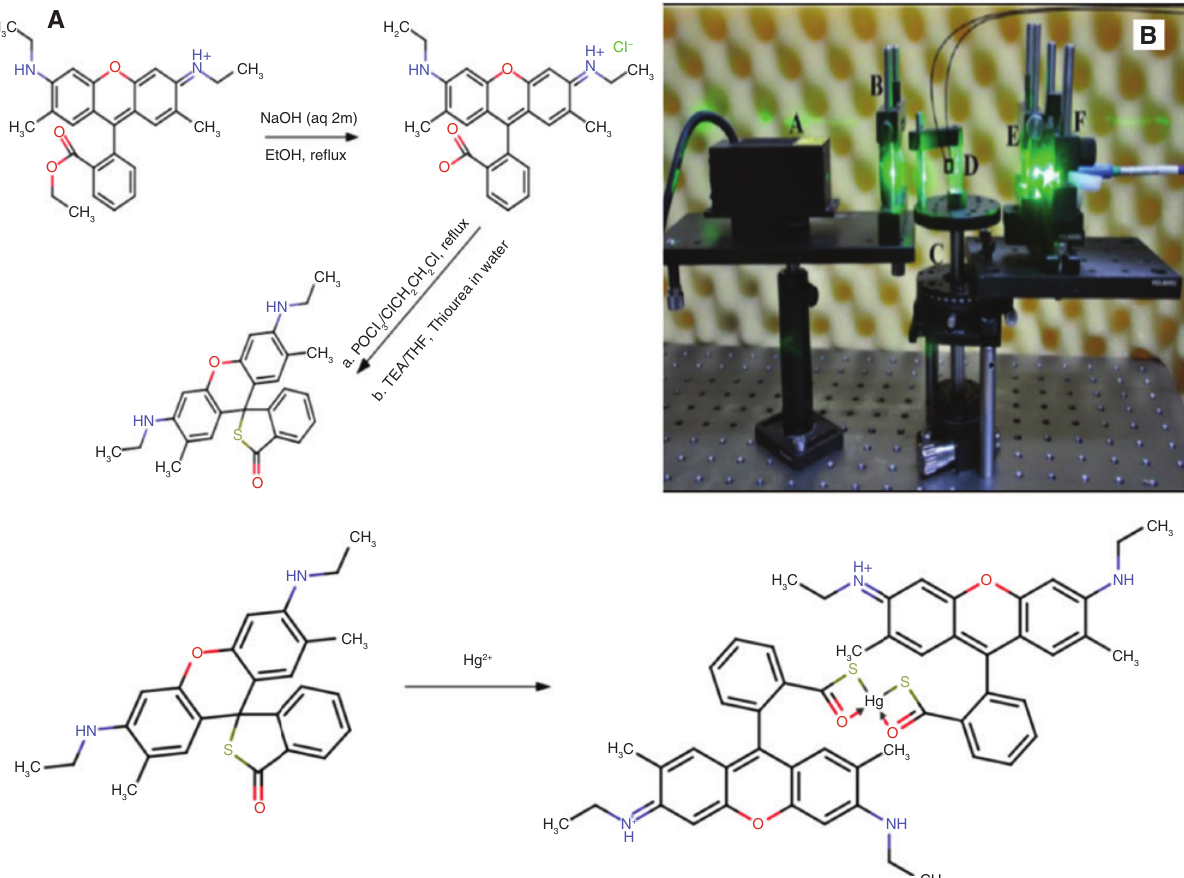
Figure 1: (A) Reaction scheme for the preparation of Rh6G D; (B) SPCE instrumental setup (A – 532 nm laser, B – aperture, C – silver slide, D – hemi-cylindrical prism, E – filter, and F – detector); and (C) Rh6G D-Hg 2 + complex formation.